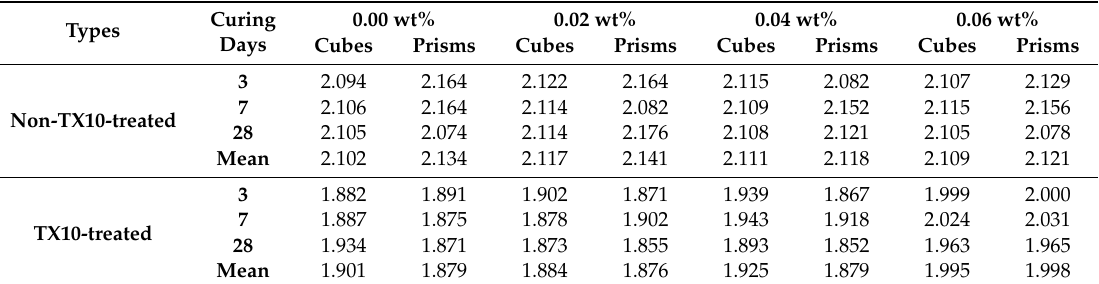
Table 13. Average bulk density of mortar specimens.